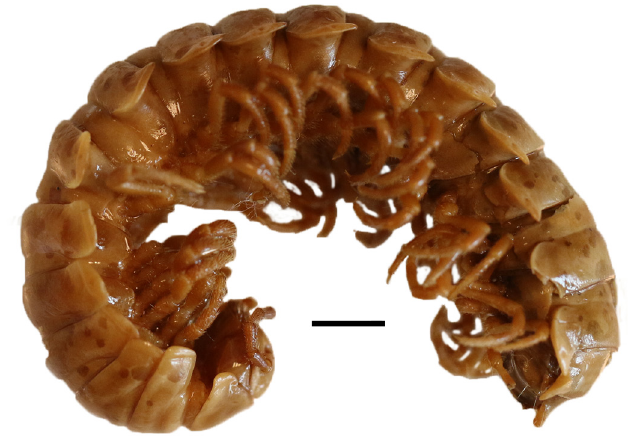
Fig. 16. Emphysemastix frampt Olsen & Enghoff sp. nov., holotype, ♂ (NHMD 621677). Scale bar: 5